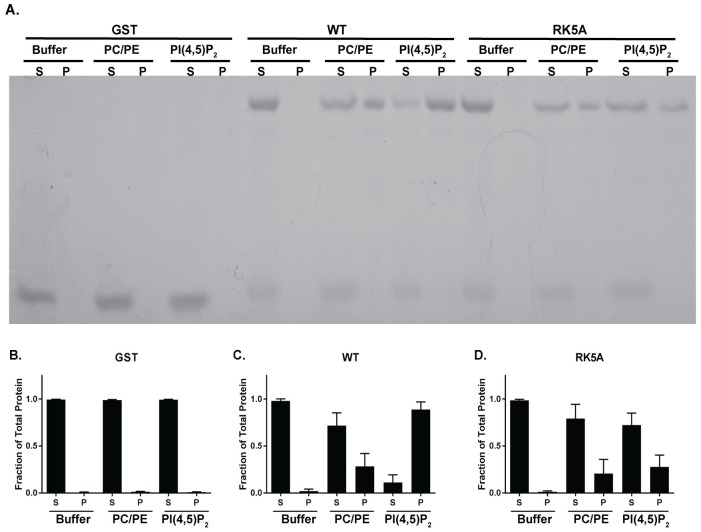
FAK catalytic domain binds PI(4,5)P2 containing lipid vesicles.GST fusion proteins were incubated in buffer alone or with large unilamellar vesicles comprised of 60%PC/40%PE (PC/PE) or 50%PC/40%PE/10% PI(4,5)P2 (PI(4,5)P2). The samples were sedimented at 100,000 x g and the supernatant (S) and pellet (P) fractions analyzed by S.D.S-PAGE and Coomassie blue staining (panel A). The results of quantification of multiple experiments (n = 6) is shown in panels B-D. The partitioning of GST (panel B), the wild catalytic domain of FAK (panel C) and the RK5A mutant catalytic domain (panel D) between supernatant (S) and pellet (P) fractions is shown. Gels were analyzed using ImageJ and the fraction of each protein in the supernatant and pellet (+/- S.D.) was plotted.